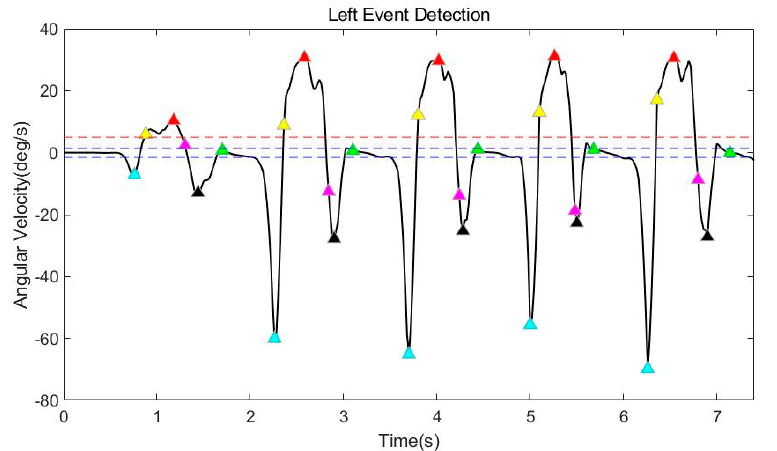
Figure 7. The result of gait event detection.